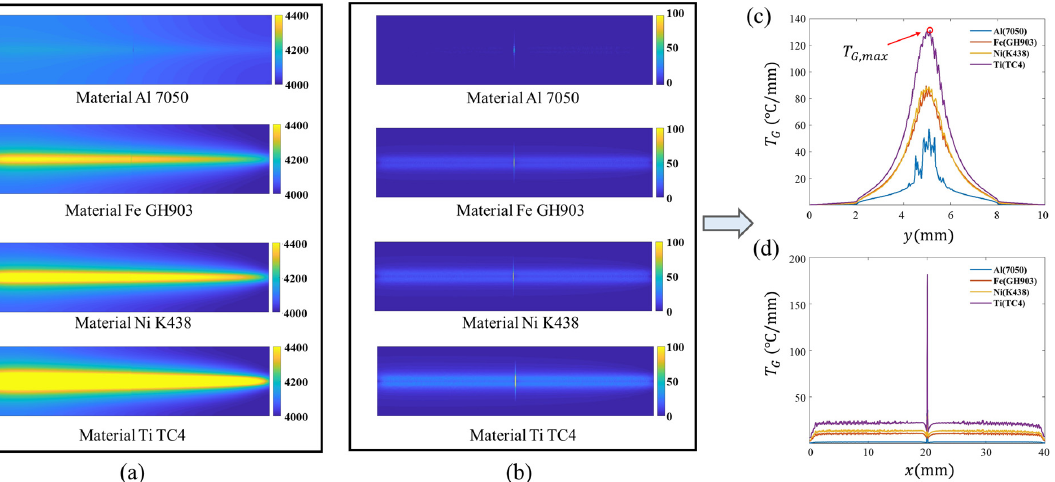
Figure 7. Crack detection for four kinds of materials with different thermomechanical properties: ( a ) superposition result of ∆ T of each frame under laser excitation; ( b ) gradient results of temperature change field T G ( T G ≥ 0 ); ( c ) T G along the crack centerline; ( d ) T G along the scan path of the laser center point.